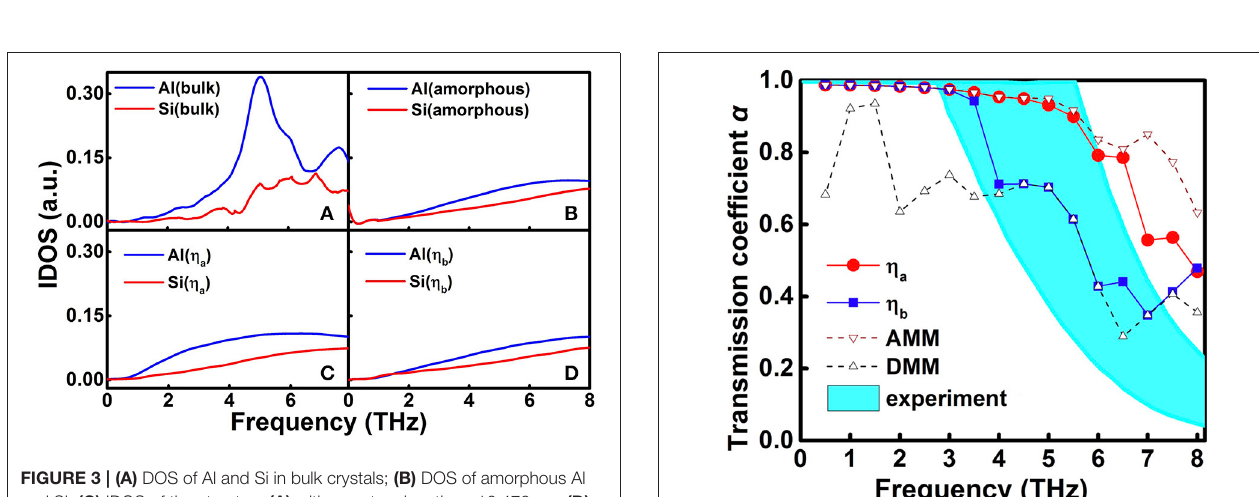
FIGURE 2 | (A) The results of thermal interface conductance calculated by AMM, DMM, and MMM. MD means our MD calculation results of ITC. η a and η b denote different interface roughness, and the roughness of η a is smaller than that of η b ; (B) The specular parameter p of structures with different interface roughness: η a and η b , which correspond with the structures in Figures 1a,b .